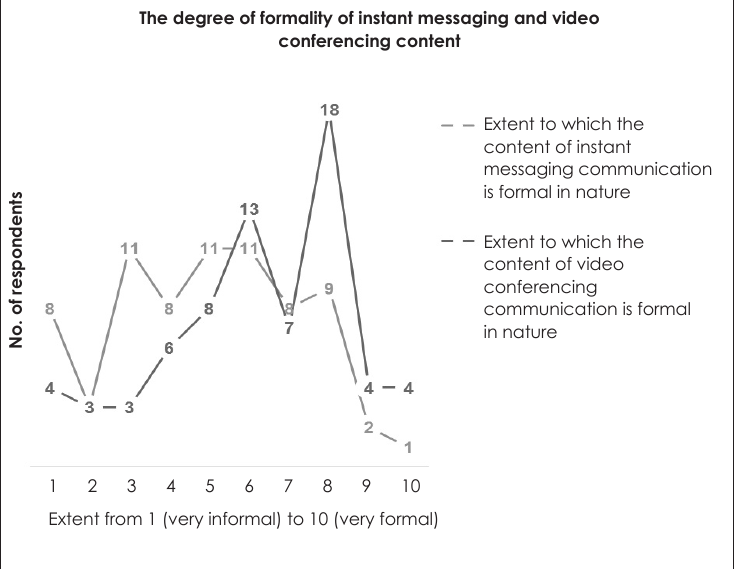
Figure 6: Extent of project CMC content formality Of the respondents, 57% perceived the content of their IM communication to be more informal, whereas 66% of the respondents perceived their VC communication to be more formal. This finding challenges existing literature, as written communication such as letters and emails are conventionally perceived to be more formal than verbal communication such as face-to-face or telephonic conversations (Turner & Müller, 2004). In this instance, the written or typed instant messages are perceived to be a more informal form of communication than the verbal and visual communication of